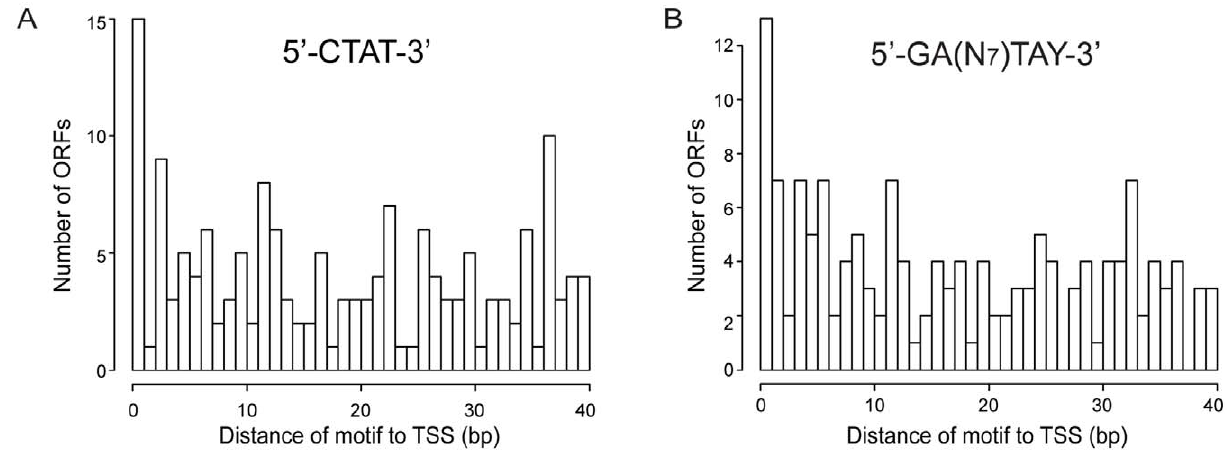
Figure 5. Histogram of distances of methylation motifs to TSS in the promoter regions. ( A ) Distances for the 5 9 -CT A T-3 9 motif to TSS. ( B ) Distances for the 5 9 -G A N 7 TAY-3 9 /3 9 -CTN 7 A TR-5 9 motif to TSS.